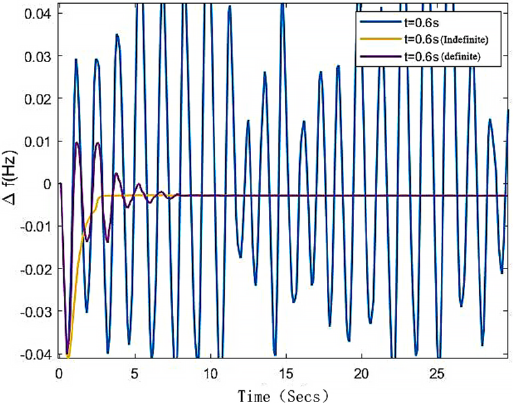
Figure 12. τ = 0.6 s system dynamic response for different prediction compensation.